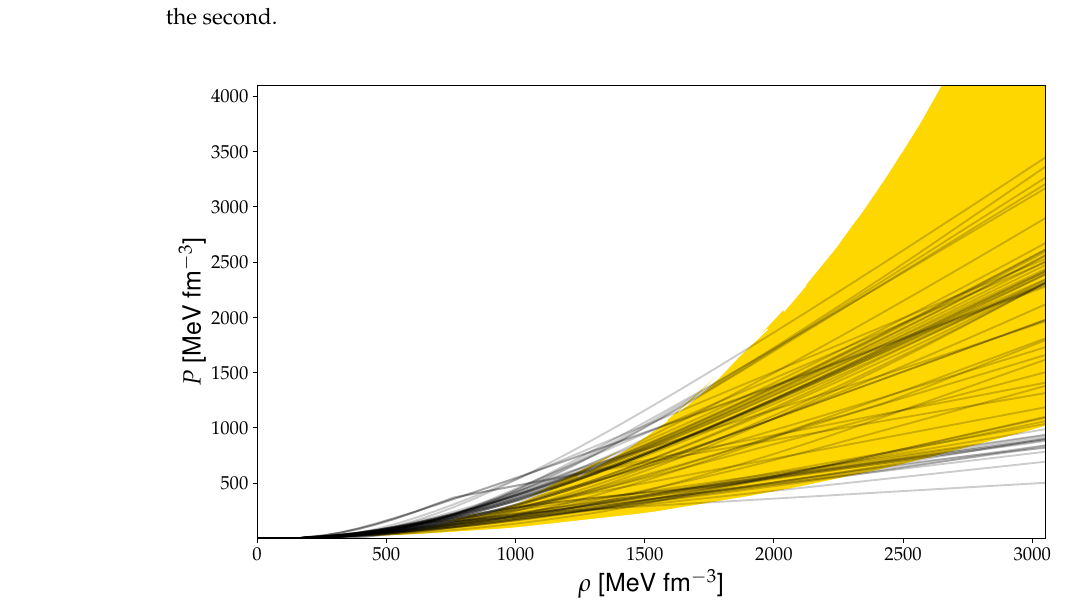
Figure 7. Representative example of heteroscedastic ( a ) and homoscedastic ( b ) residuals. Notice how the variance of the residuals changes with the value of x for the first, while it remains constant for the second.